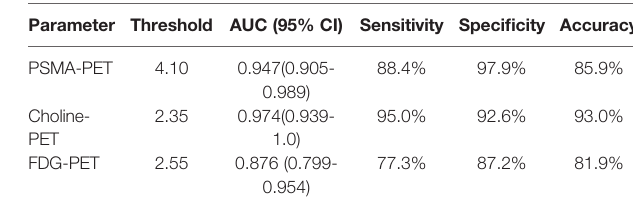
TABLE 2 | Identi fi cation ef fi ciency between lymph node metastasis and ganglia.